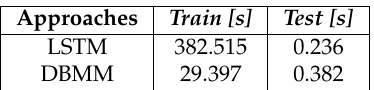
Table 11. Elapsed time for Training and